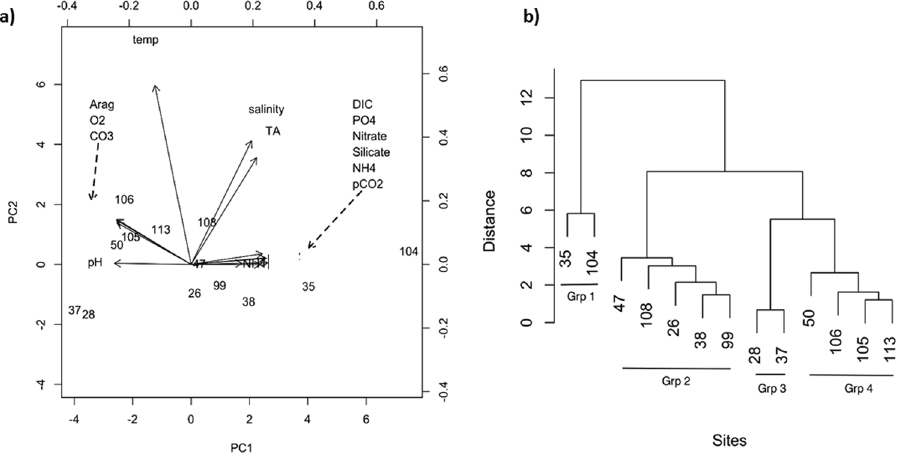
Figure 2. Relationships among collection sites in terms of water chemistry in the natural environment using principal coordinate’s analysis and cluster analyses. ( a ) The environmental variables were highly correlated, with multicollinearity between different parameters (e.g., between carbonate ion, Ω , and O 2 ) and thus, loading overlap on the left figure (dashed arrows indicating overlapping symbols). ( b ) Cluster analyses of the water chemistry at the stations of pteropod collection showed similarity among the stations in environmental parameters, and resulted in four clearly identified groups: Group 1 (stations 35 and 104); Group 2 (stations 47, 108, 26, 38, and 99); Group 3 (stations 28 and 37); and Group 4 (stations 50, 106, 105, and 113), with average Ω ar ~ 1.2 for Groups 3 and 4, Ω a ~ 1 for Group 2, and Ω ar ~ 0.75 for Group 1 (Supplementary Table S3). Biological responses were analyzed based on these cluster